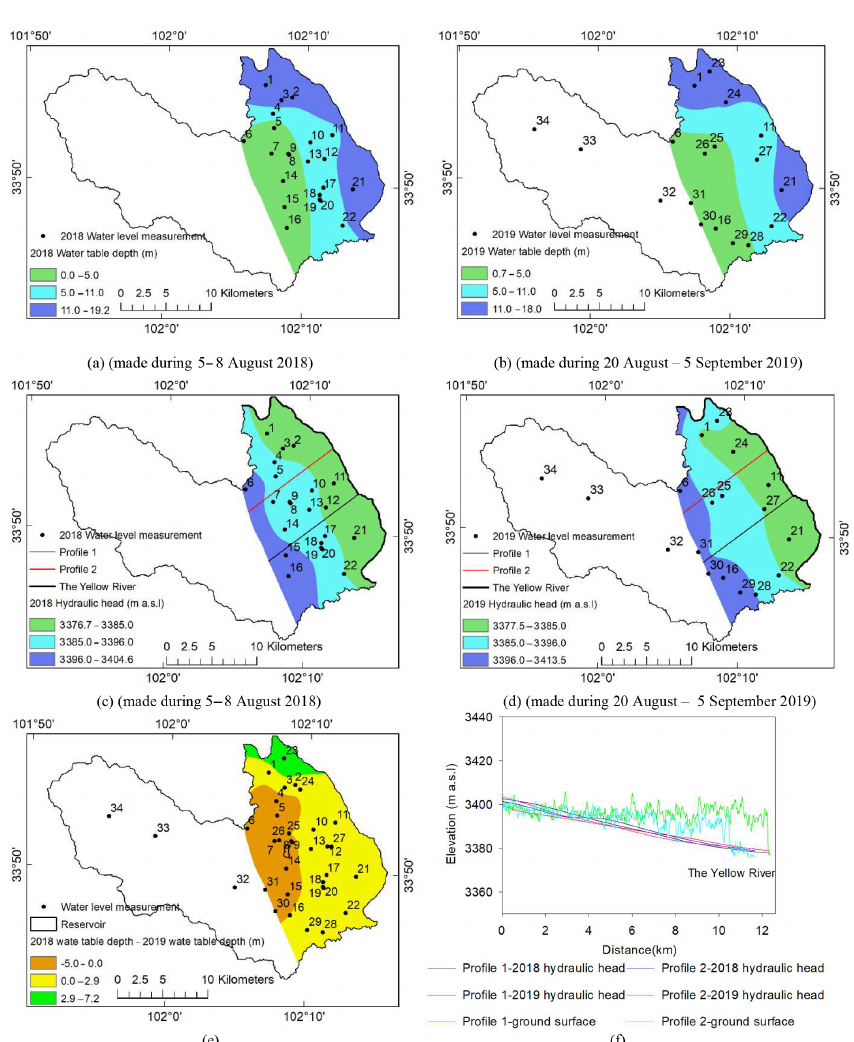
Figure 9. Water table depths (m) and piezometric heads (ma.s.l.) of the eastern Maqu catchment. Panels (a) and (b) are water table depths (m) of the eastern Maqu catchment in 2018 and 2019, respectively; (c) and (d) are piezometric heads (ma.s.l.) of the eastern Maqu catchment in 2018 and 2019, respectively; (e) is the difference (m) in water table depth between 2018 and 2019; (f) is the profile 1 and profile 2 showing the hydraulic head and ground surface, with the profile locations shown in Fig. 9c and d. Numbers from 1 to 34 are identification numbers of